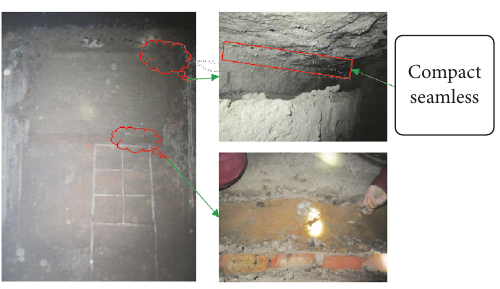
Figure 12: The filling effect on